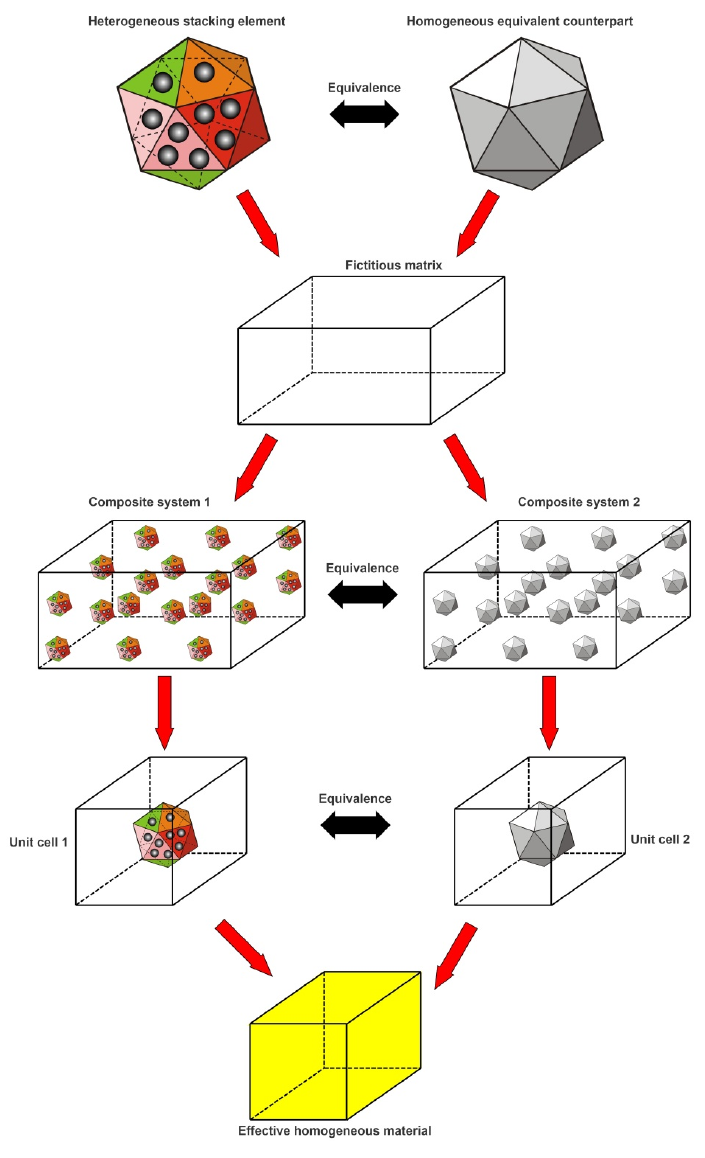
Figure 9. Schematic diagram of basic procedure of the present method for arbitrary stacking element.